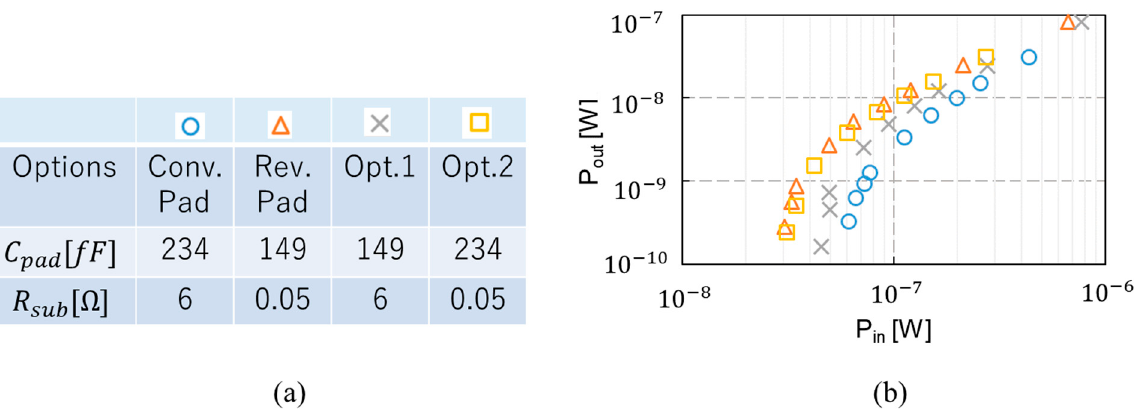
Figure 9. Four options ( a ) and their P in − P out ( b ).